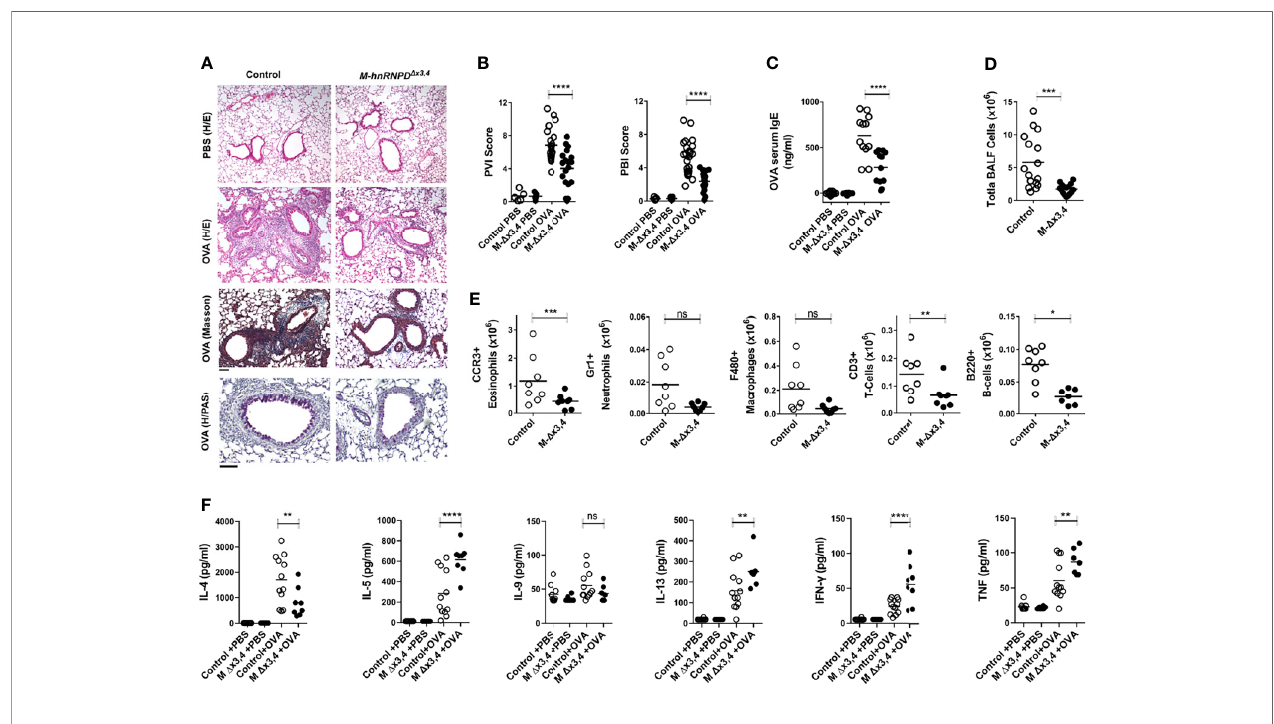
FIGURE 3 | The ablation of AUF1s functions in myeloid cells attenuates the development of allergic-airway in fl ammation. (A) Representative histology of lung tissue from control and M- D x3,4 mice at the endpoint of treatment with aerosolized Ovalbumin (OVA). Photomicrographs of paraf fi n-embedded sections stained with Hematoxylin & Eosin (H&E) for the generic assessment of pathological features of peribronchial and perivascular in fl ammation in mice treated either with OVA or PBS vehicle; as well as Masson trichrome for fi brosis and Periodic Acid Schiff (PAS) for bronchial mucus metaplasia in OVA challenged mice. Scale bar corresponds to 50 m m. (B) Estimation of Perivascular (PVI) and Peribronchial (PVI) In fl ammation Score in Control and M- D x3,4 mice. Scatter plots indicate individual values and means (lines) derived from the scoring of H&E stained sections derived from n=17-22 mice/genotype. (C) Quantitation of total anti-OVA IgE in the sera of control and M- D x3,4 mice challenged with OVA or PBS vehicle. Scatter plots indicate individual values and means (lines) as assessed via ELISA of sera from n=11 mice/ genotype. (D) Endpoint quantitation of total cell numbers in BALF from Control and M- D x3,4 mice treated with OVA. Scatter plots indicate individual values and means (lines) as assessed via coulter counting of BALFs from n=15-17 mice/genotype. (E) Absolute quantitation of distinct cellular subsets in the BALF of Control and M- D x3,4 mice treated with OVA. Scatter plots indicate individual values and means (lines) as assessed via the fl ow cytometric analysis of BALFs from n=8 mice/ genotypeanalyzed via the gating strategy indicated in Figure S3 . (F) Detection of T-helper lymphokines in the BALFs from control and M- D x3,4 mice challenged with OVA or PBS vehicle. Scatter plots indicate individual and mean protein values (line) as detected via cytometric bead arrays. For graphs in (B – F) (ns, *, **, ***, ****) denote p values > 0.05, ≤ 0.05, ≤ 0.001, ≤ 0.0001, ≤ 0.00001 respectively as determined via One-Way